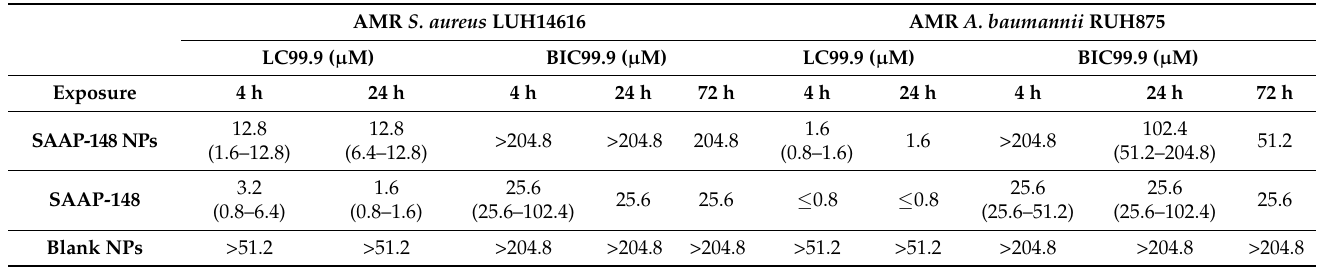
Table 1. In vitro killing activity of formulated and unformulated peptides against planktonic and biofilm composed of AMR S. aureus and A. baumannii